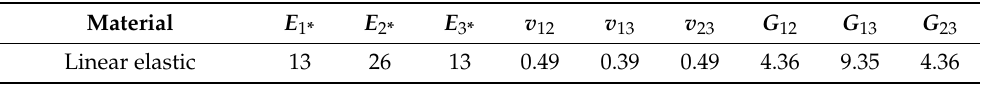
Table 4. Engineering constants: Young’s modulus, Poisson ratio, and shear modulus in the three principal directions.